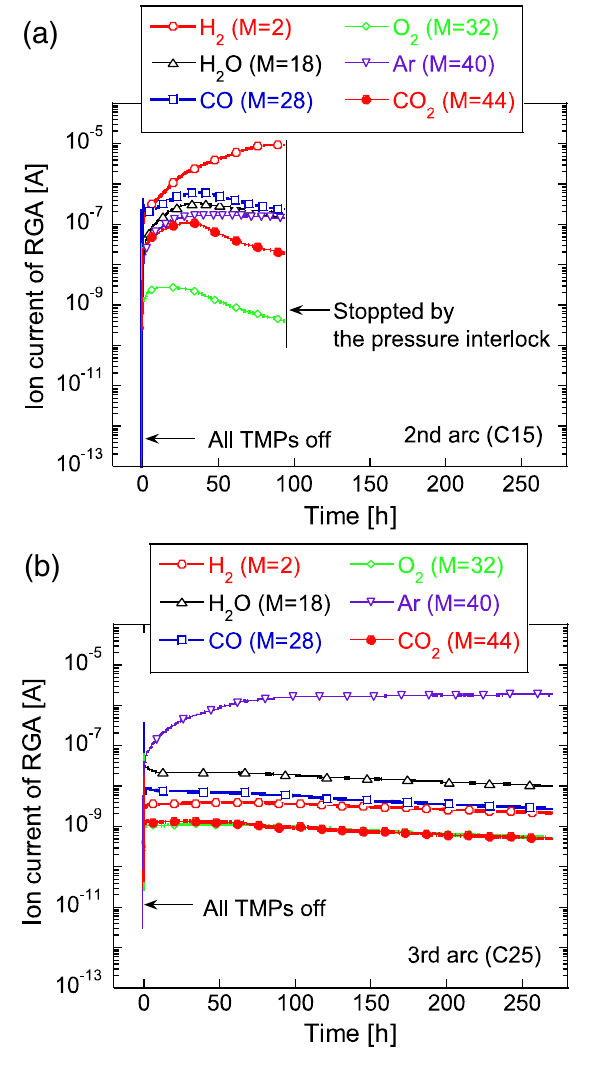
FIG. 27. Time variation of the RGA ion current for typical gas mass numbers during the buildup test. The origin of the horizontal axis is set to the time when the TMPs are stopped. (a)Resultofthesecondarc sectionwithoutNEGpumps.(b)Result of the third arc section with NEG pumps. In the second arc, the RGA is switched off at around 94 h by the interlock which is set for the total pressure to 2 × 10 − 3 Pa. It should be noted that the absolute ion current between the different RGAs cannot be compared because their sensitivities are